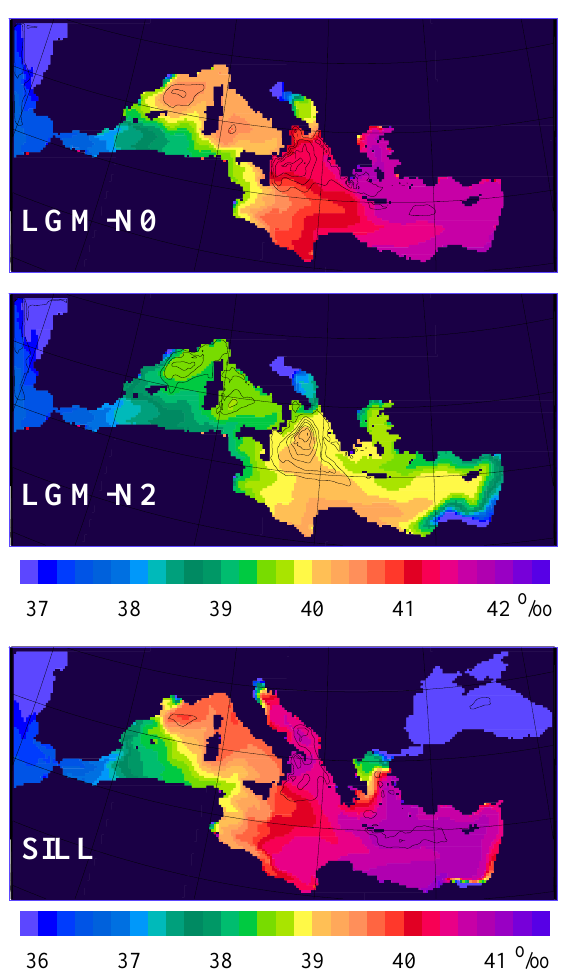
Fig. 14. Simulated annual mean surface salinity (colours, con- tour interval 0.2‰) and climatological maximum mixed layer depth (isolines, contour interval 250m) for sensitivity experiments. The panels show the LGM experiments with modified Nile discharge: suppressed (LGM-N0) and doubled (LGM-N2) Nile discharge and the present day sensitivity experiment with reduced sill depths in the Straits of Gibraltar and Sicily. Cf. Figs. 11 top and 3.